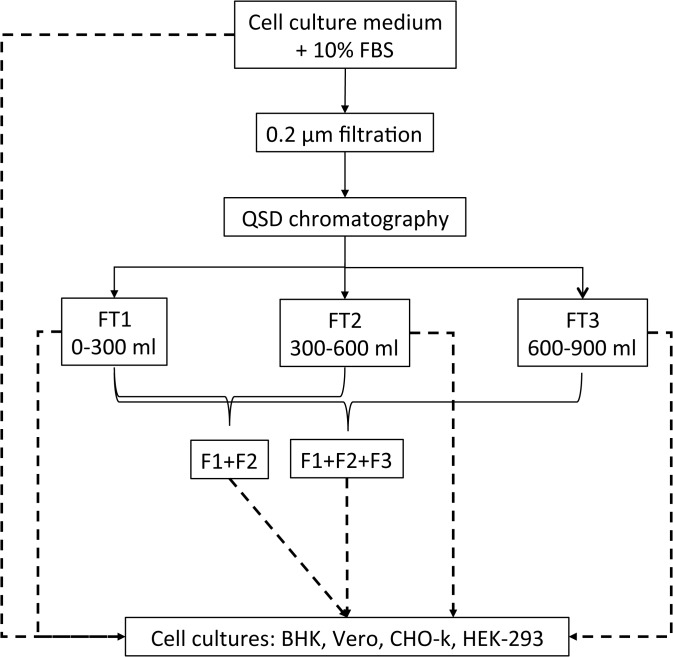
Experimental design for assessing the impact of the QSD filtration of growth media on cell growth.Three flow-through fractions (FT1, FT2, FT3) from the QSD column have been obtained and tested either individually, or after pooling (F1+F2; F1+F2+F3) to determine their capacity to support cell growth. Details of the procedure are described in the Material and Methods section.